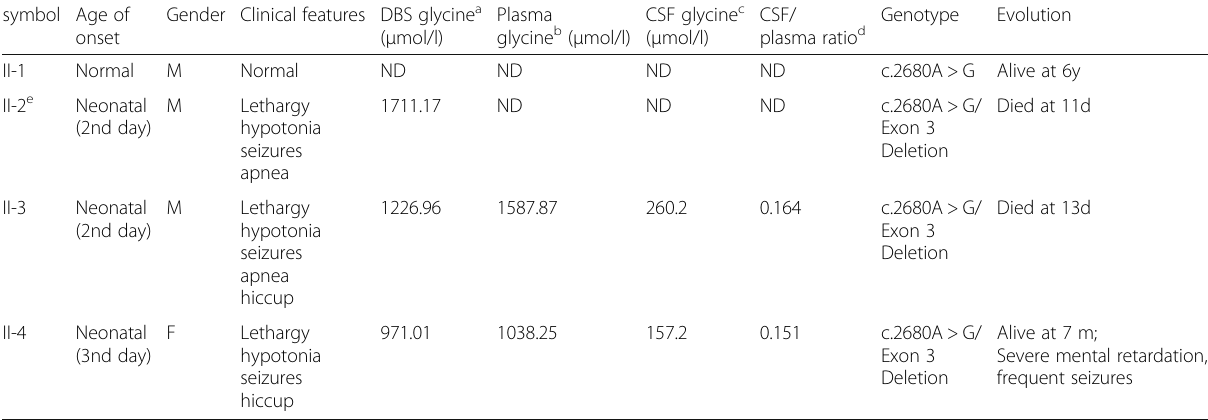
Table 1 Clinical, biochemical and genetic characteristics of the siblings symbol Age of Gender Clinical features DBS glycine a ( μ onset